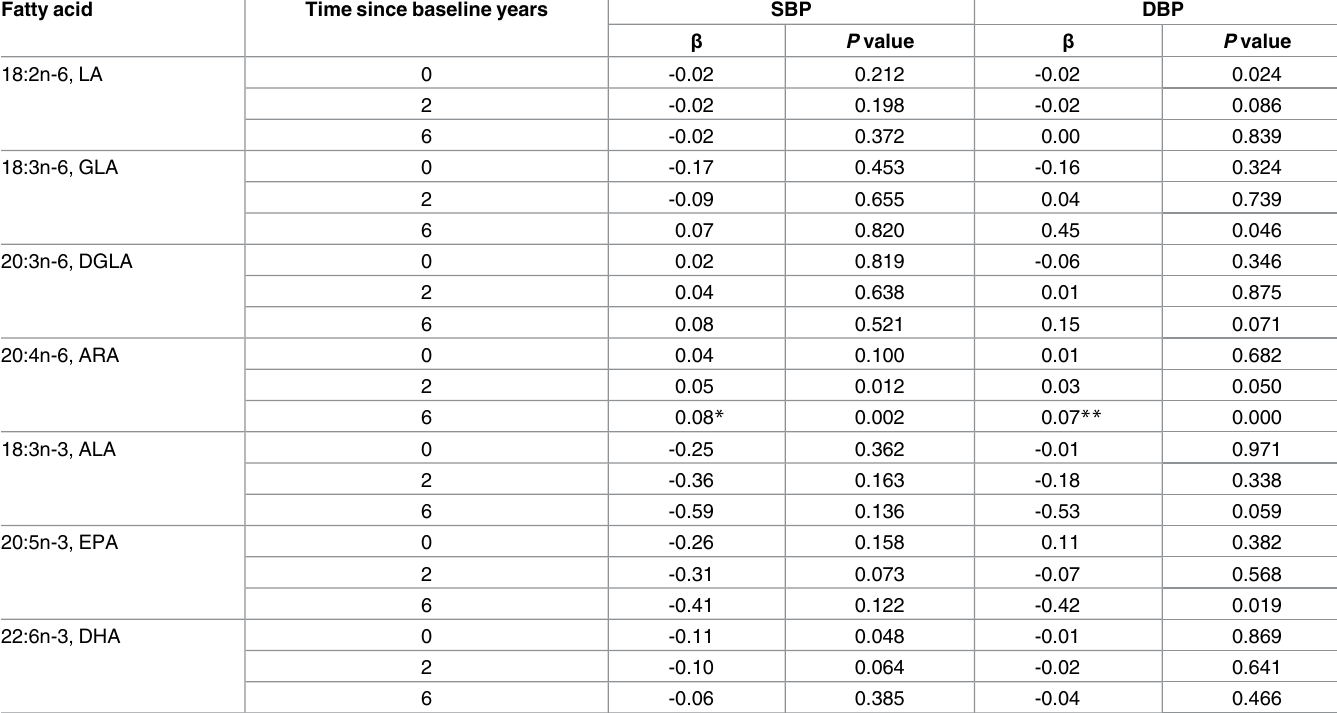
Table 2. Associations of polyunsaturated fatty acids with systolic and diastolic blood pressure z-scores at baseline, after 2 years and after 6 years of follow-up estimated based on fully adjusted mixed-effects models 1 . Fatty acid Time since baseline years